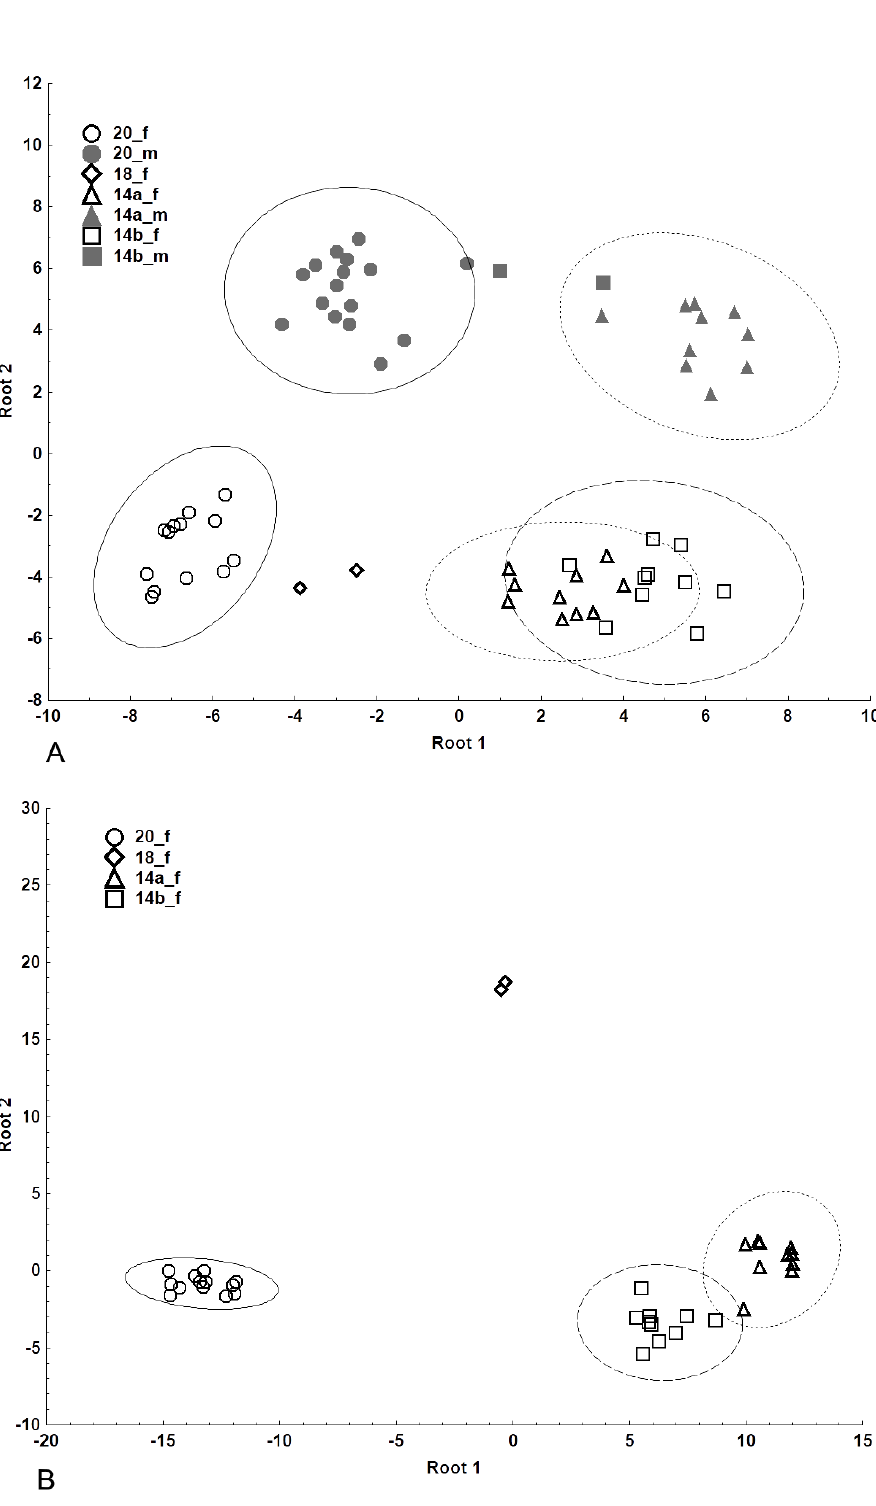
Fig. 4. DFA based on 11 counts, two coded characters, and 55 relative measurements, for males and fe- males separately ( A ) and for females only ( B ). Numbers of samples or clades as in Fig. 3. Abbreviations: f = females; m = males. DFA statistics values: A . Wilks’ Lambda 0.00000, approx. F (156.189) = 11.390, p < 0.0000. B . Wilks’ Lambda 0.00002, approx. F (48.48) = 36.279, p < 0.0000